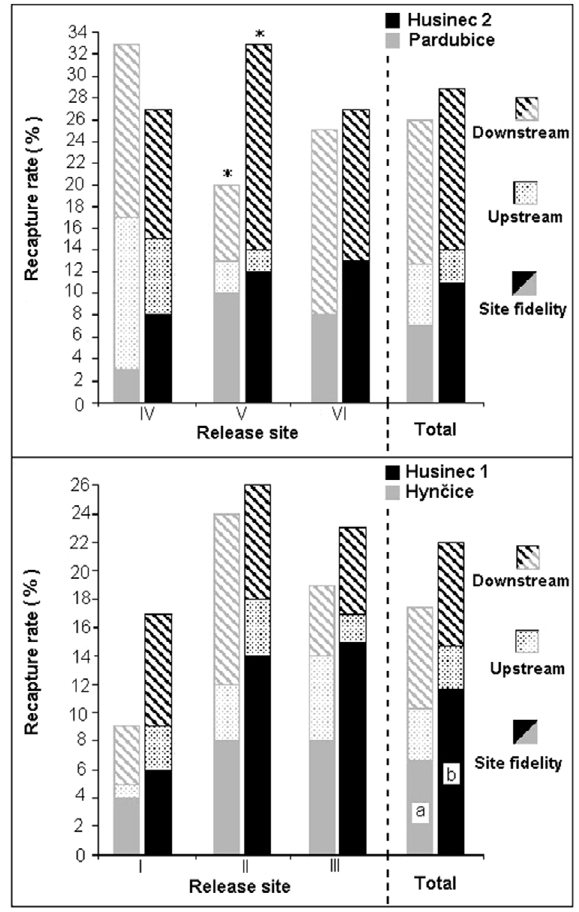
Fig. 2. Recapture rate (site fi delity= recapturing into release site/ upstream = recapturing up of release site/downstream =recapturing down of release site) of stocked grayling in each site and total values (right column). * above bars indicates a signi fi cant difference ( P < 0.05) in total recapture rate, different letters in bars indicate a signi fi cant difference ( P < 0.05) in site fi delity/upstream/downstream recapture rate.